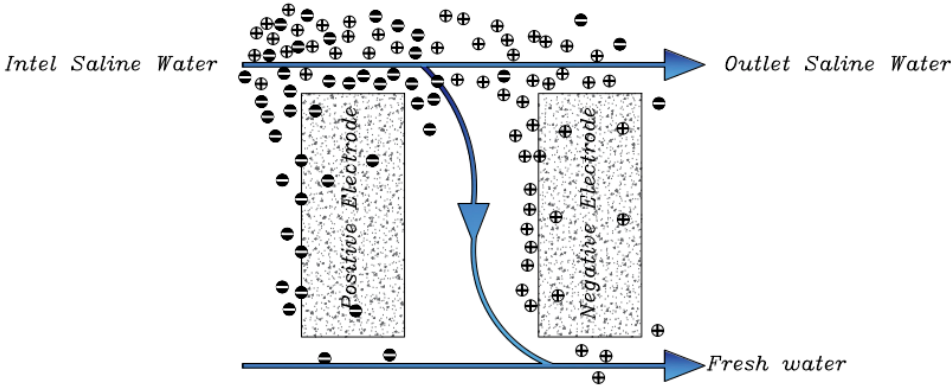
Figure 6. Installed electrostatic ion pumping in a CDI cell.